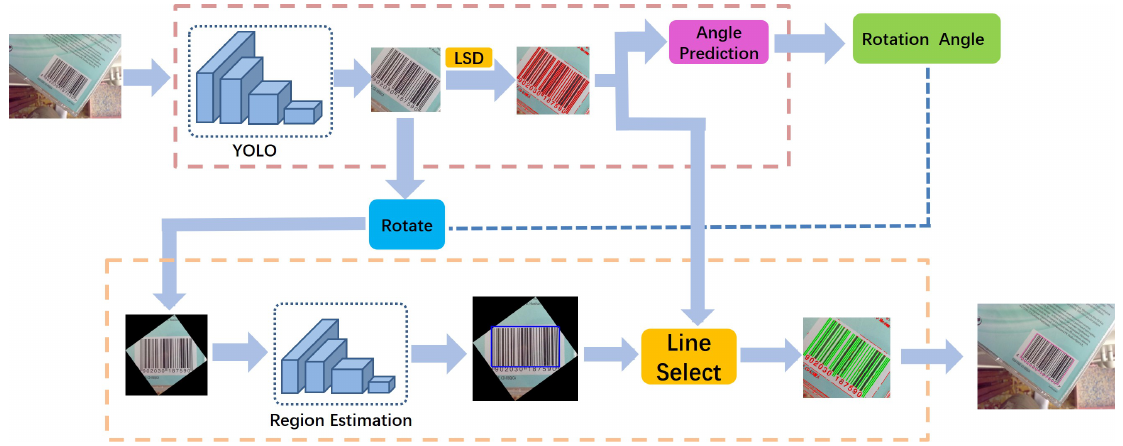
Figure 1. Overview of our